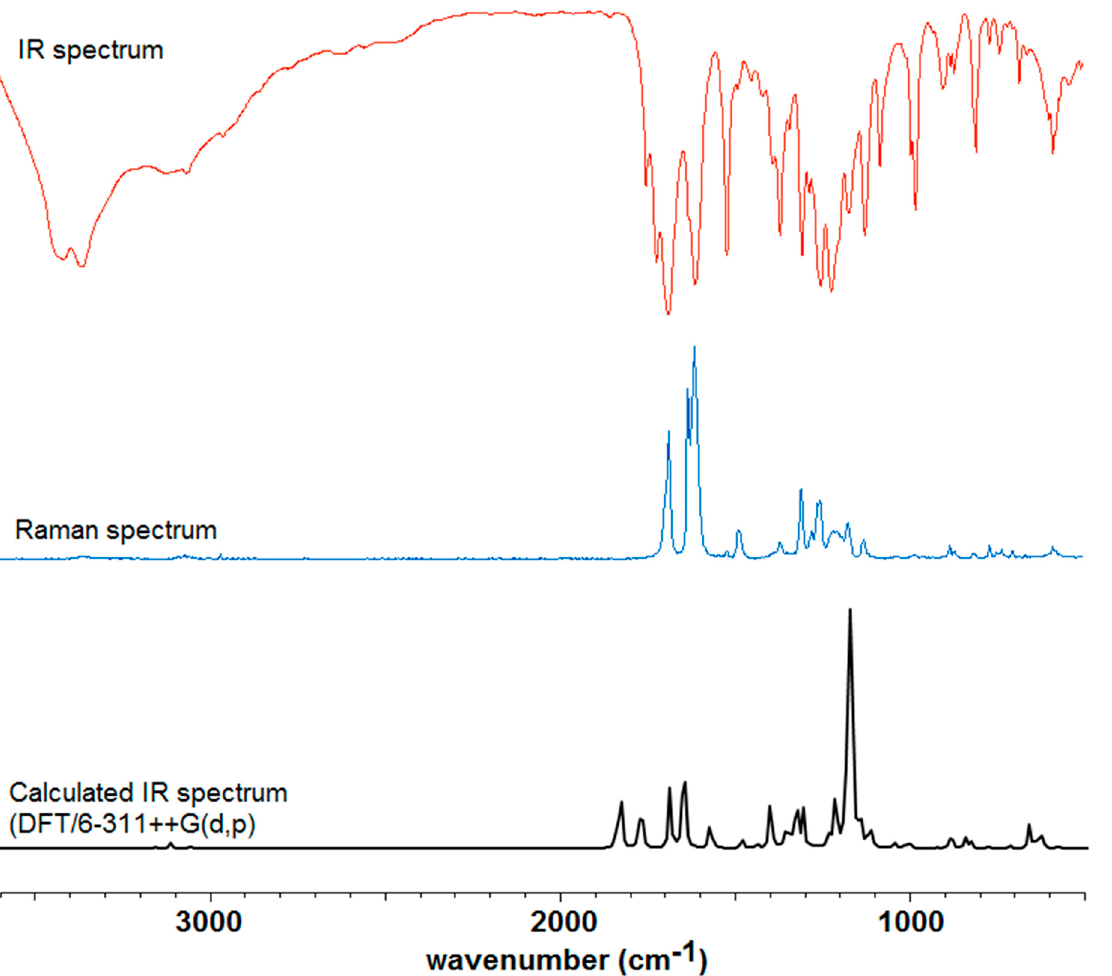
Figure 1. Experimental infrared (IR), Raman and calculated IR spectra of cichoric acid.